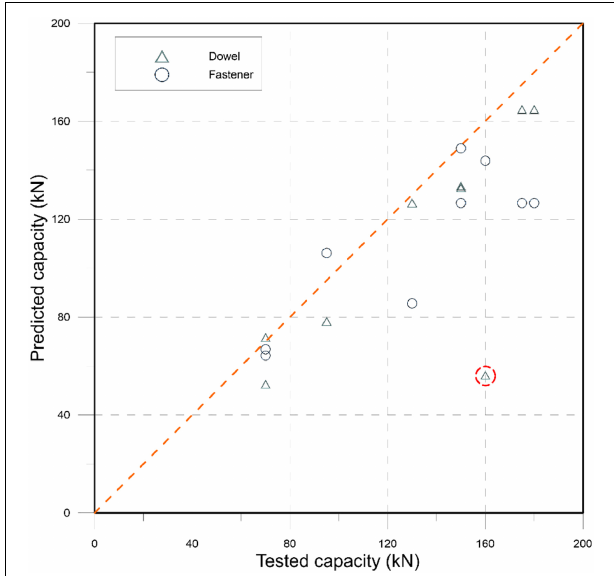
FIGURE 6 | Predicted capacity vs. tested capacity for the “dowel” and “fastener” models.